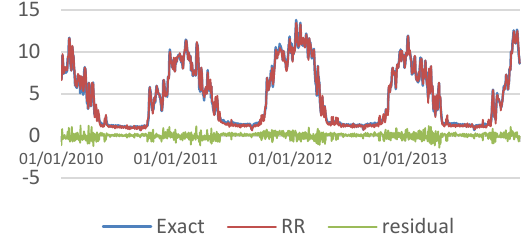
Figure 7. Exact values and RR approximation of natural gas consumption for one-week ahead prediction based on test